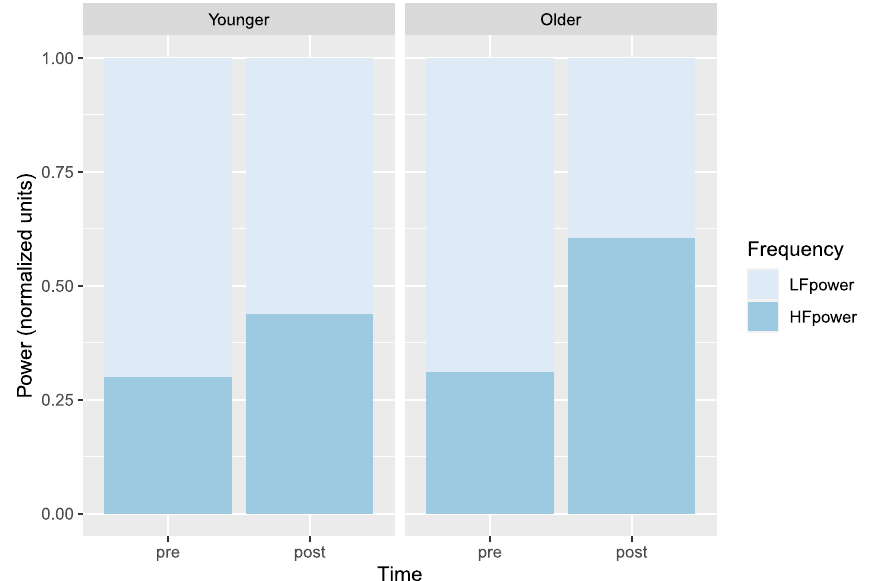
Figure 2. HF and LF repartition according to time and age.